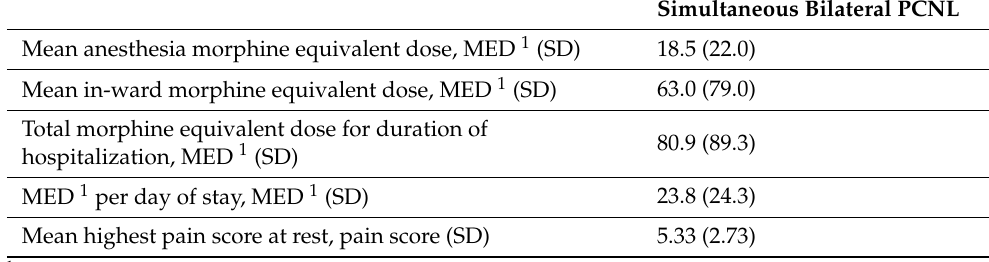
Table 4. Opioid-use and pain